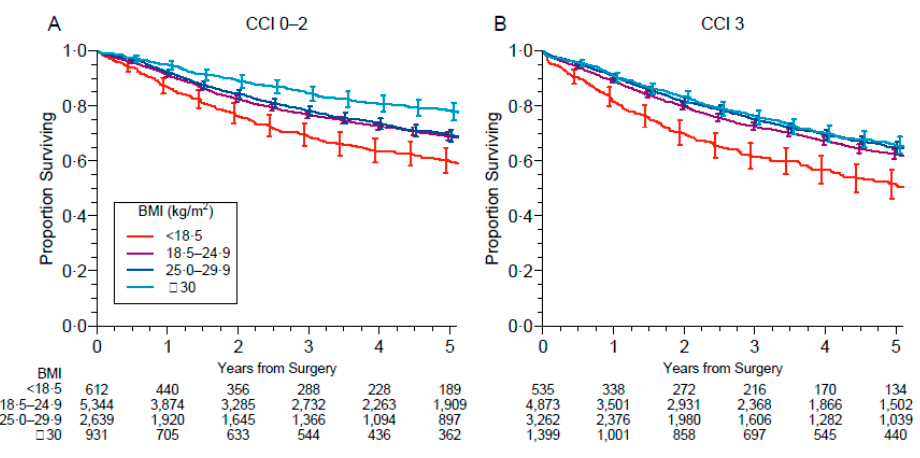
Figure 4. Survival according to BMI and Charlson comorbidity index (CCI) categories: 0–2 ( A ), 3 ( B ), 4–5 ( C ), >6 ( D ). Figure 5 shows survival according to obesity categories. Remarkably, the negative association of obesity with risk was stronger for higher BMIs, with a maximum protective effect in patients with BMI ≥ 40 kg/m 2 .